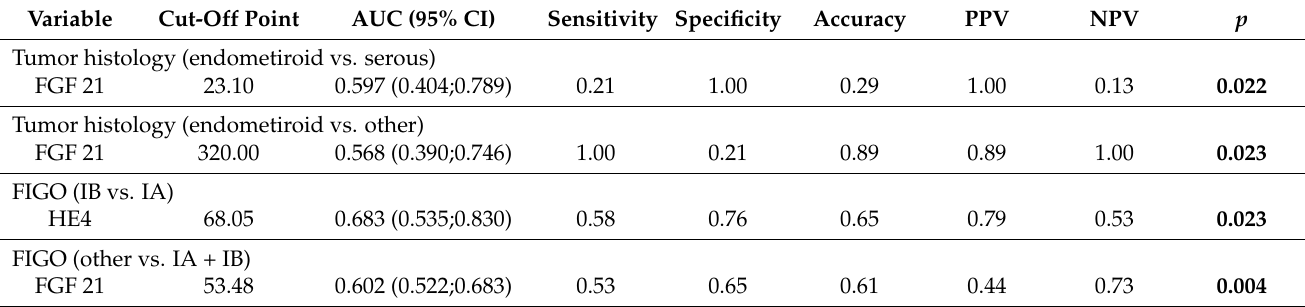
Table 7. Diagnostic performance of FGF 21, CA 125, and HE4, accounting for tumor